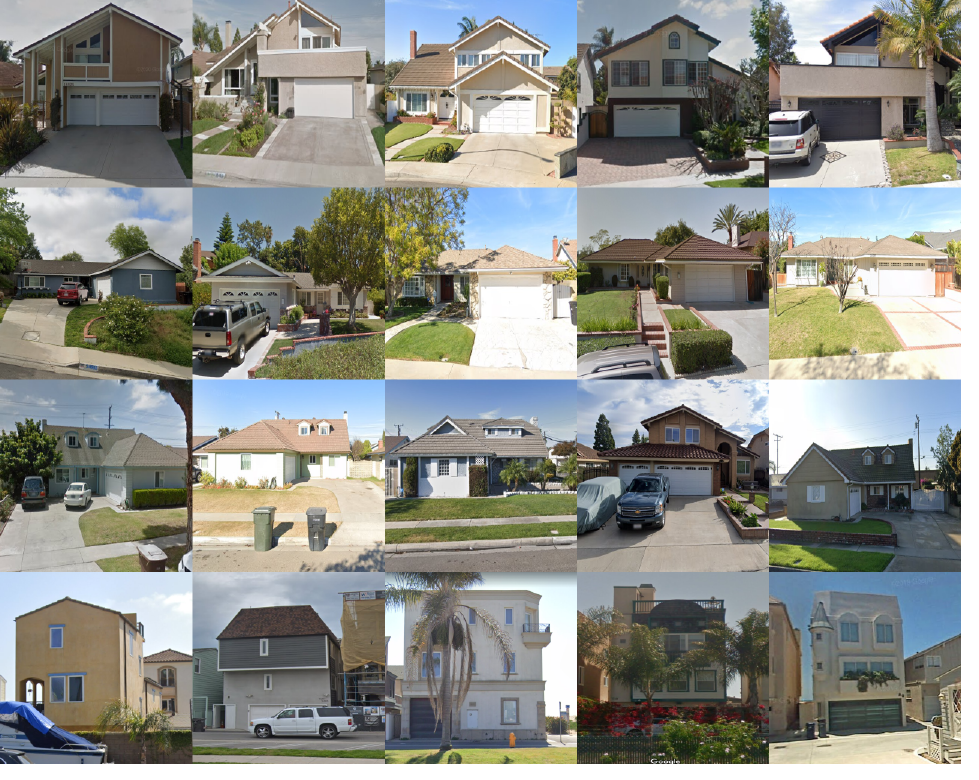
Figure 11. Sample of properties in 4 different delineated neighborhoods (1 neighborhood per